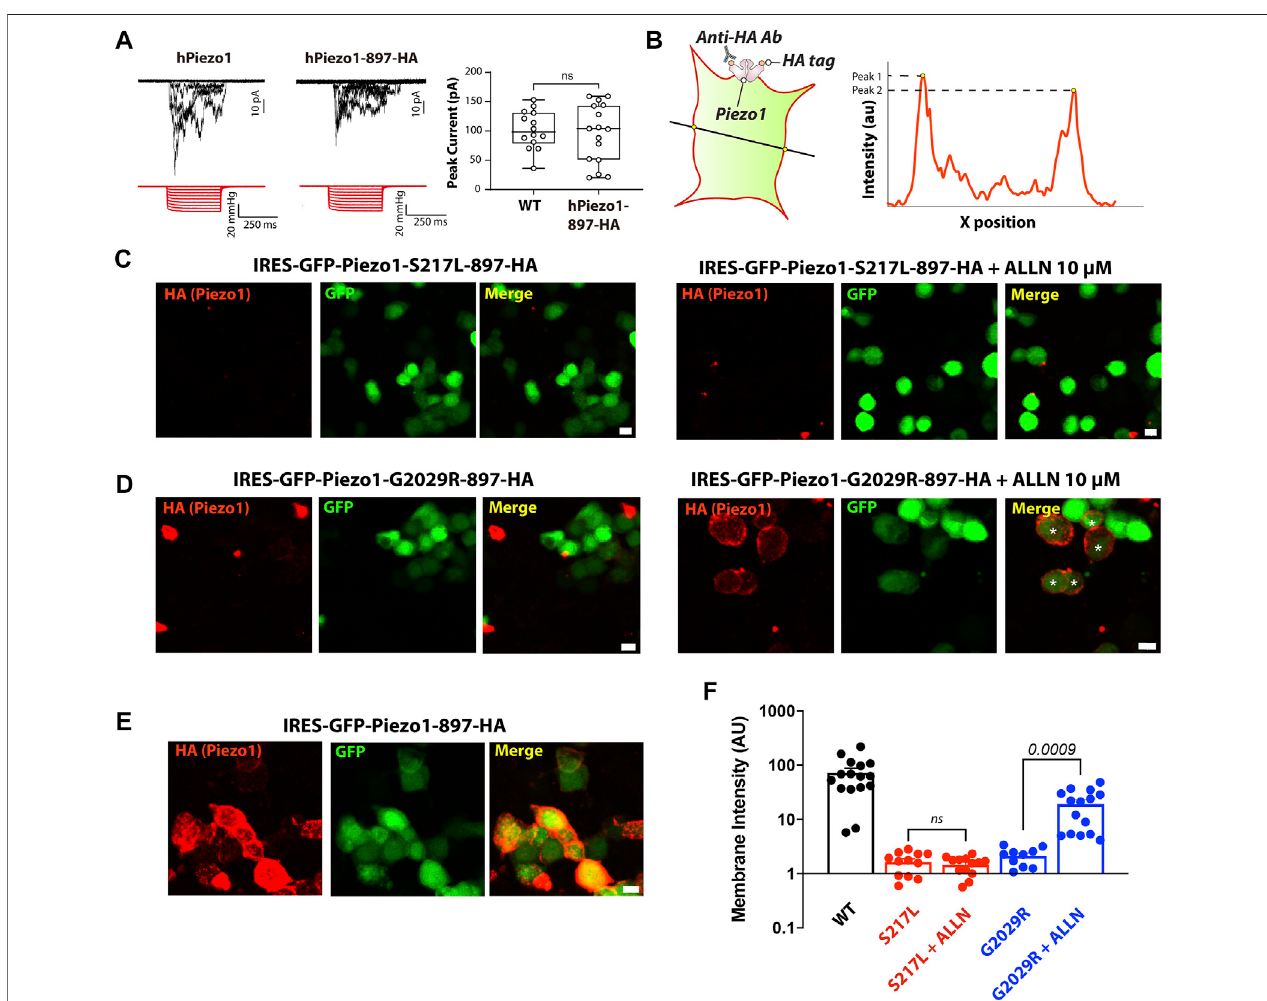
FIGURE 4 | ALLN partially rescues the membrane-localization of G2029R. (A) Piezo1 − / − HEK293T cells overexpressing WT or Piezo1-897HA were subjected to cell-attached patch clamping. Representative traces in responseto square wave negative pressure pulses are shown. The right panel shows the summary data of peak currents elicited from cell-attached patches as a box and whiskers plot illustrating the minimum and maximum. (B) Schematic showing how the membrane intensity is calculated. A straight line was drawn across the GFP positive cells with only the GFP channel visible to preclude bias. The peak value of the HA signal within the membrane region, determined by GFP channel and bright fi eld, was determined using Image J ’ s Plot Pro fi le tool. Peak values on each side of the cell were averaged as onedatapoint. (C – E) Piezo1 − / − HEK293TcellsoverexpressingWTormutantPiezo1withanextracellular897-HAtagwerestainedwithanti-HAantibodyandAlexa-555 goat anti mouse secondary antibody before PFA fi xation. All fi gures were taken under the same optical con fi guration and presented with the same maximum/minimum intensity. Red channel, signal from HA antibody; green channel, signal from free GFP. Scale bar, 10 µm. (F) Summary data from Panels (C – E) . Y axis represents membrane intensity in arbitrary fl uorescent units. Comparison between treated and untreated cells was caried out using Student ’ s t-test.